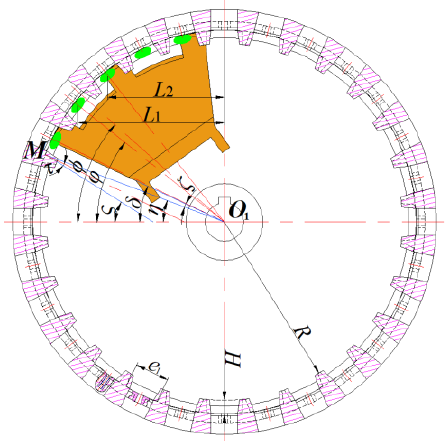
Figure 5. Schematic diagram of seed-cleaning scraper installation position. Note: M , the lower vertex of the lower bottom edge of the front surface of the filling hole; L 1 , distance between mass center of cotton seed adsorbed on the suction hole ’s end surface which is between the first and second segment scrapers and the vertical axis of the seeding plate, mm; L 2 , distance between mass center of cotton seed adsorbed on the suction hole ’s end surface at the second segment scraper and the vertical axis of the seeding plate, mm; R , inner circle radius of seeding plate, mm; H , filling-hole height, mm; e 1 , width of lower bottom surface of the type hole at the plane where the suction holes axes are located, mm; δ , starting installation angle of seed-cleaning scraper, (°); η , angle of the straight line MO 1 with horizontal axis of seeding plate, (°); ς , critical slip angle of the cotton seed at the plane where the suction holes axes are located, (°); τ , angle of the type hole sidewall with the axis of the corresponding suction hole at the plane where the suction holes axes are located, (°); ζ , angle of straight line MO 1 with the corresponding suction hole axis, (°); ϕ , angle between the symmetrical centerline of the first and second segment scrapers and the horizontal axis of seeding plate, (°); and φ , angle of the suction hole axis which is between the first and second segment scrapers with the horizontal axis of the seeding plate, (°).